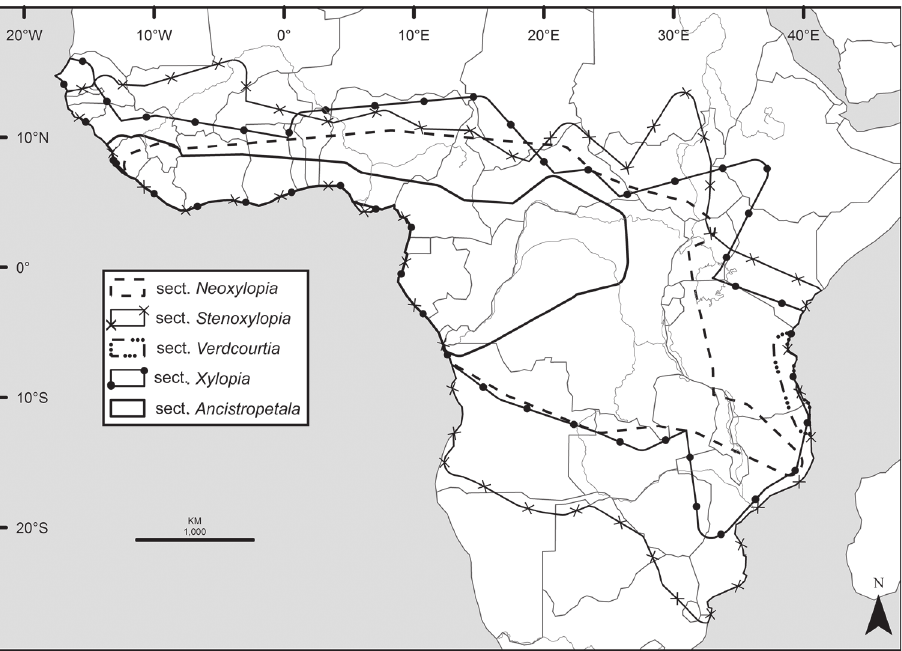
Figure 7. Aggregate distributions of the sections of Xylopia present in Africa. Distributions are as de- scribed in this work, based on the phylogenetic analysis of Stull et al. (2017), but with the addition of sect. Verdcourtia . Bolder lines represent country borders, fainter lines lakes and major